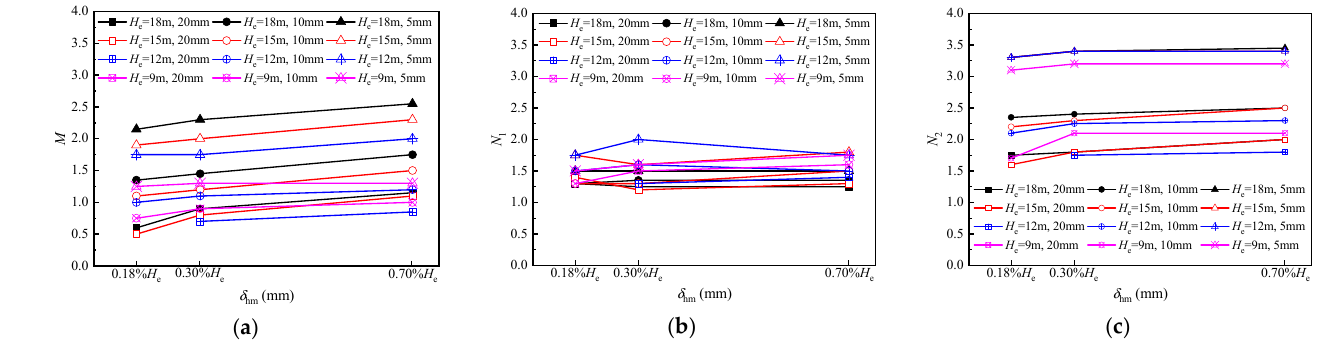
Figure 11. E ff ect of δ hm on M , N 1 and N 2 : ( a ) E ff ect of δ hm on M ; ( b ) E ff ect of δ hm on N 1 ; ( c ) E ff ect of Figure 11. Effect of δ hm on M , N 1 and N 2 : ( a ) Effect of δ hm on M ; ( b ) Effect of δ hm on N 1 ; ( c ) Effect of δ hm on N 2 . δ hm on N 2 .